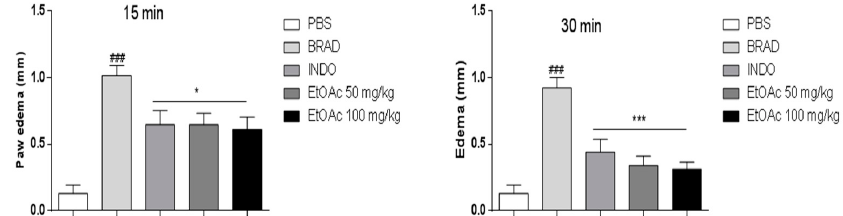
Figure 5. Reduction of paw edema (induced by bradykinin challenge) in the presence of EtOAc of A. occidentale at 15 and 30 min. Results were expressed as mean SEM and analysed by graphpad Prism using ANOVA followed by the test Dunnett or Mann–Whitney, where all groups were compared. ### p < 0.001 versus PBS group and * p < 0.05; *** p < 0.001 versus carragenan group.